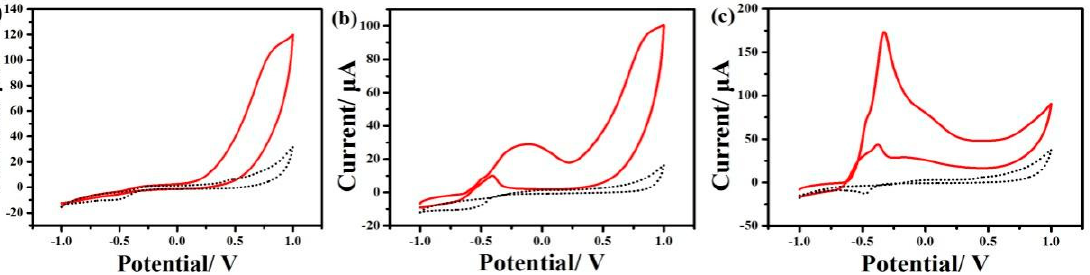
Figure 4. CVs of COFs/GCE ( a ), Pd 2+ /GCE ( b ), Pd 2+ /COFs/GCE ( c ) in the absence (dotted line) and presence (solid line) of 5 mM hydrazine at a scan rate of 100 mV s − 1 , respectively. (Electrolyte: 0.1 M NaOH).